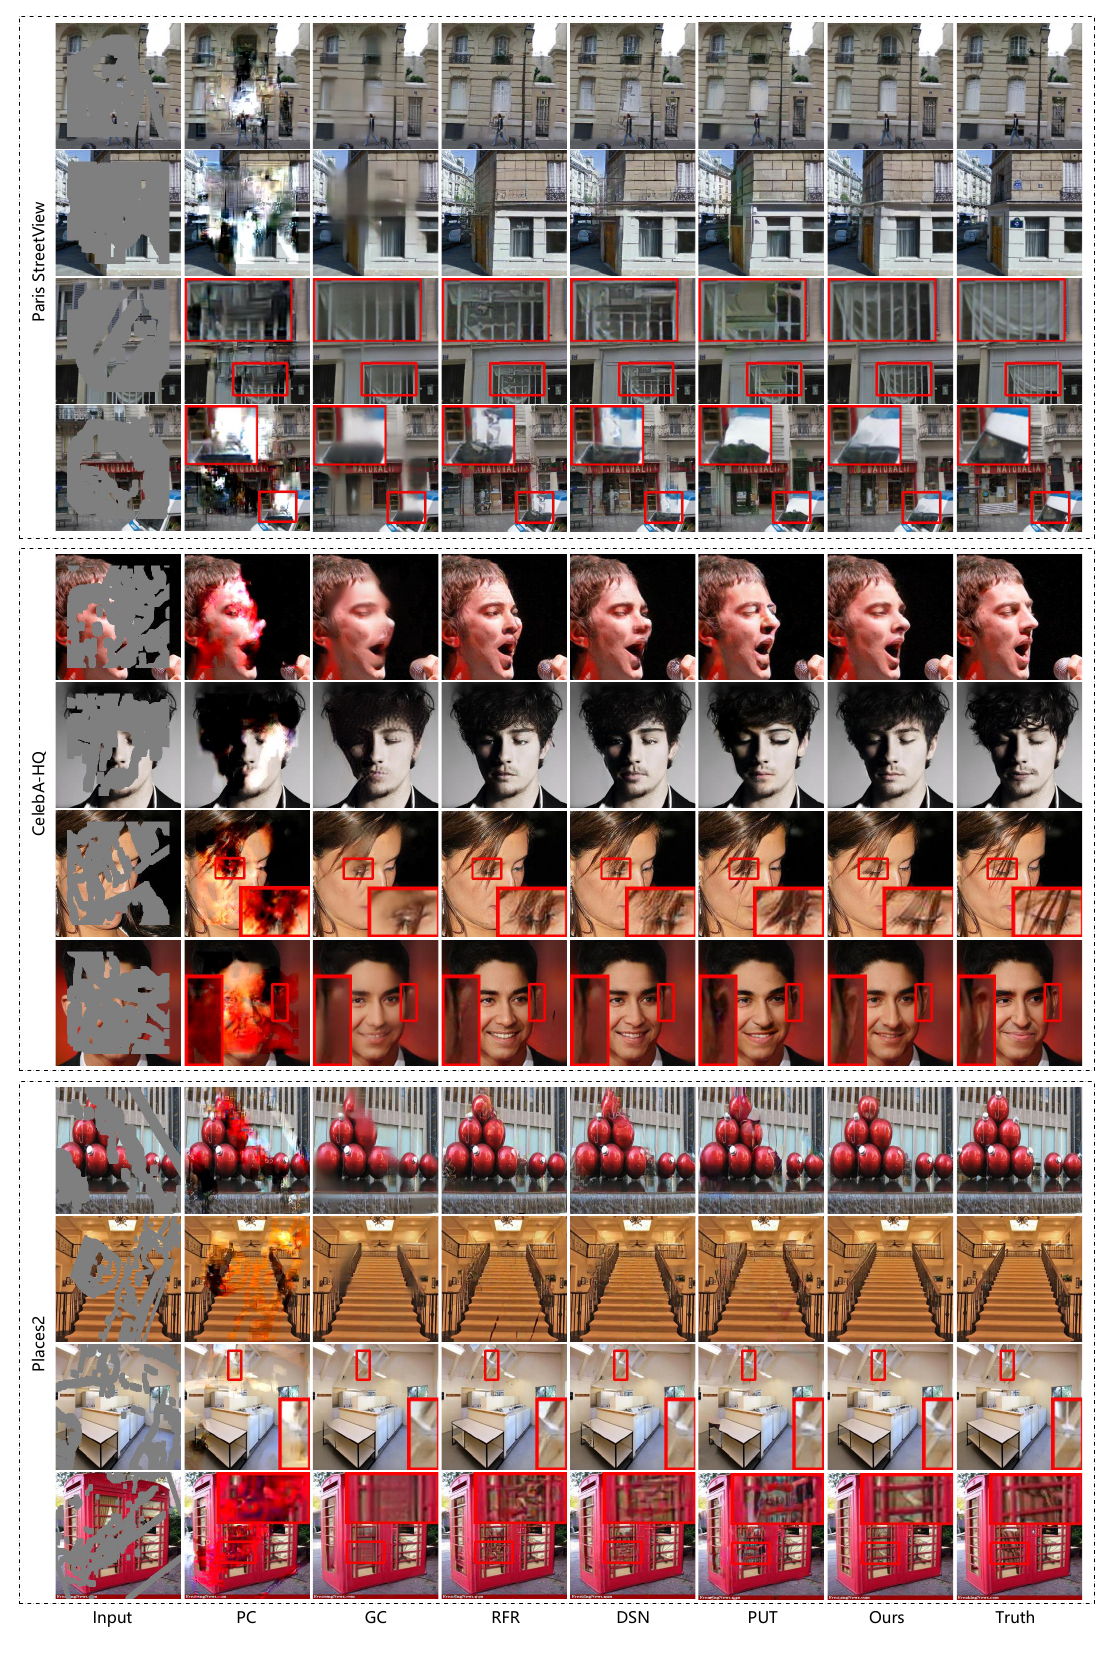
Figure 6. Qualitative results of typical image inpainting datasets (Paris StreetView, CelebA-HQ, and Places2). Local details are displayed in the red